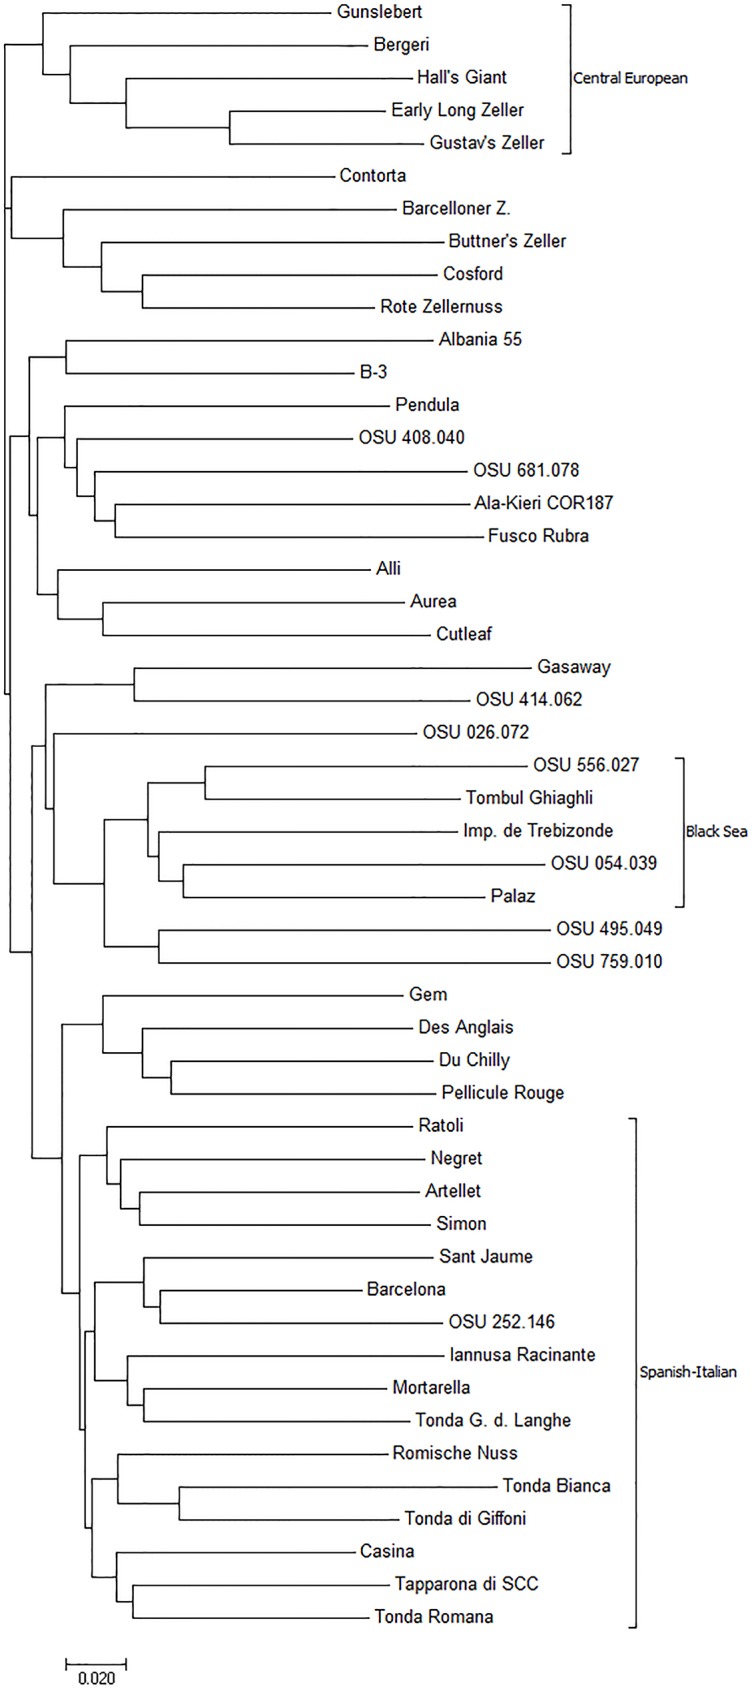
Neighbor-joining dendrogram of 50 hazelnut accessions constructed from binary data for 150 new simple sequence repeat markers.